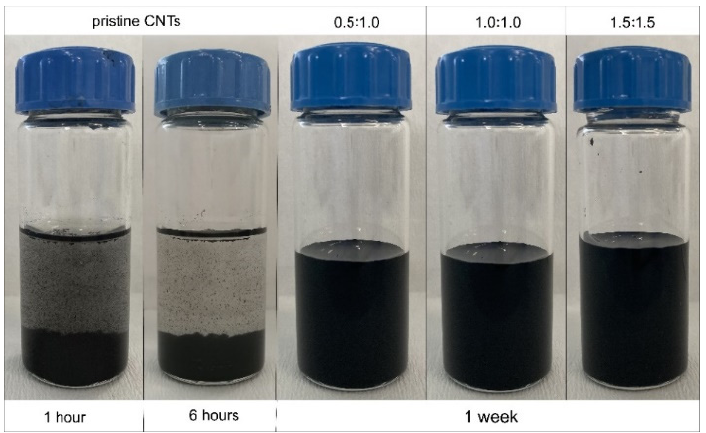
Figure 6. Dispersion and stability state of the CNTs in water with and without CNC. The ink compositions are represented from CNTs/CNC—0.5:1; CNTs/CNC—1:1; CNTs/CNC—1.5:1.5, left to right.